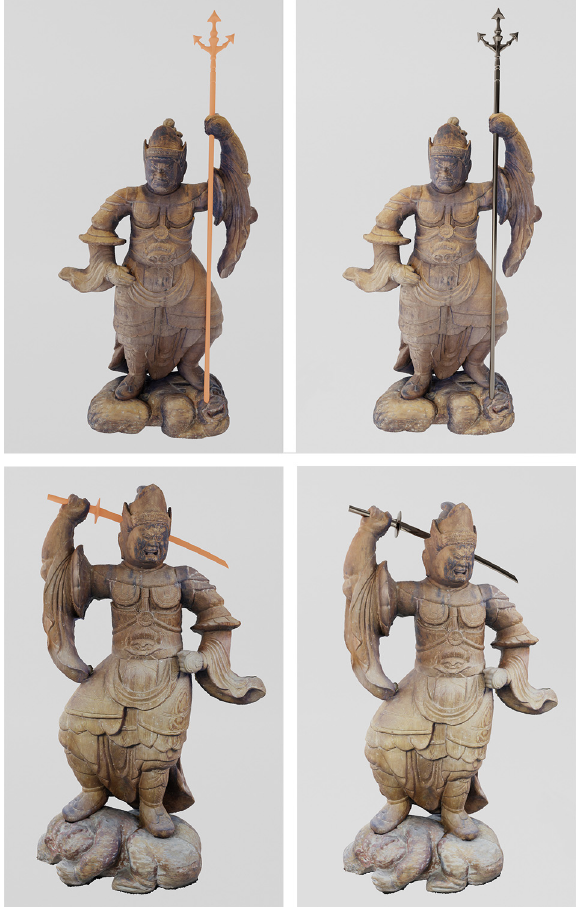
Figure 5 . .Digital reconstruction of Ni-Tennō’s weapons. Conceptual and rendered models. Modelling: S.